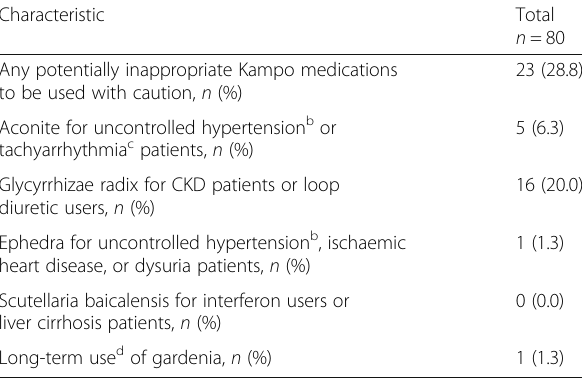
Table 3 Prevalence of the use potentially inappropriate Kampo medications to be used with caution a in elderly patients taking any prescribed Kampo medications